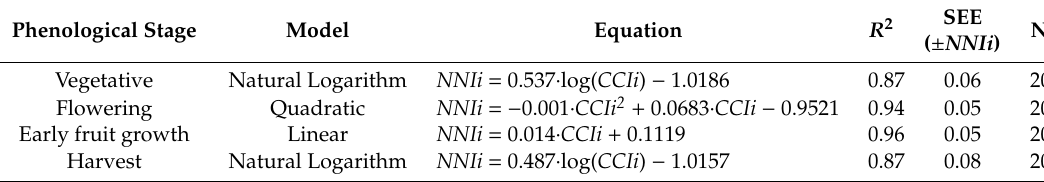
Table 8. Coefficients of determination ( R 2 ) of regressions between integrated chlorophyll content index ( CCIi ) values and the integrated nitrogen nutrition index ( NNIi ) for each phenological stage in a sweet pepper ( Capsicum annuum ) in 2017. The crop was subjected to five different N treatments with four repetitions. According to the Akaike information criterion, the best-fit regression model (exponential, linear, power, quadratic, and natural logarithm) is shown. Also, it is presented the fitted equation and standard error of the estimate (SEE). All regressions were highly significant, with p - value < 0.001. N is the number of data points of regression.